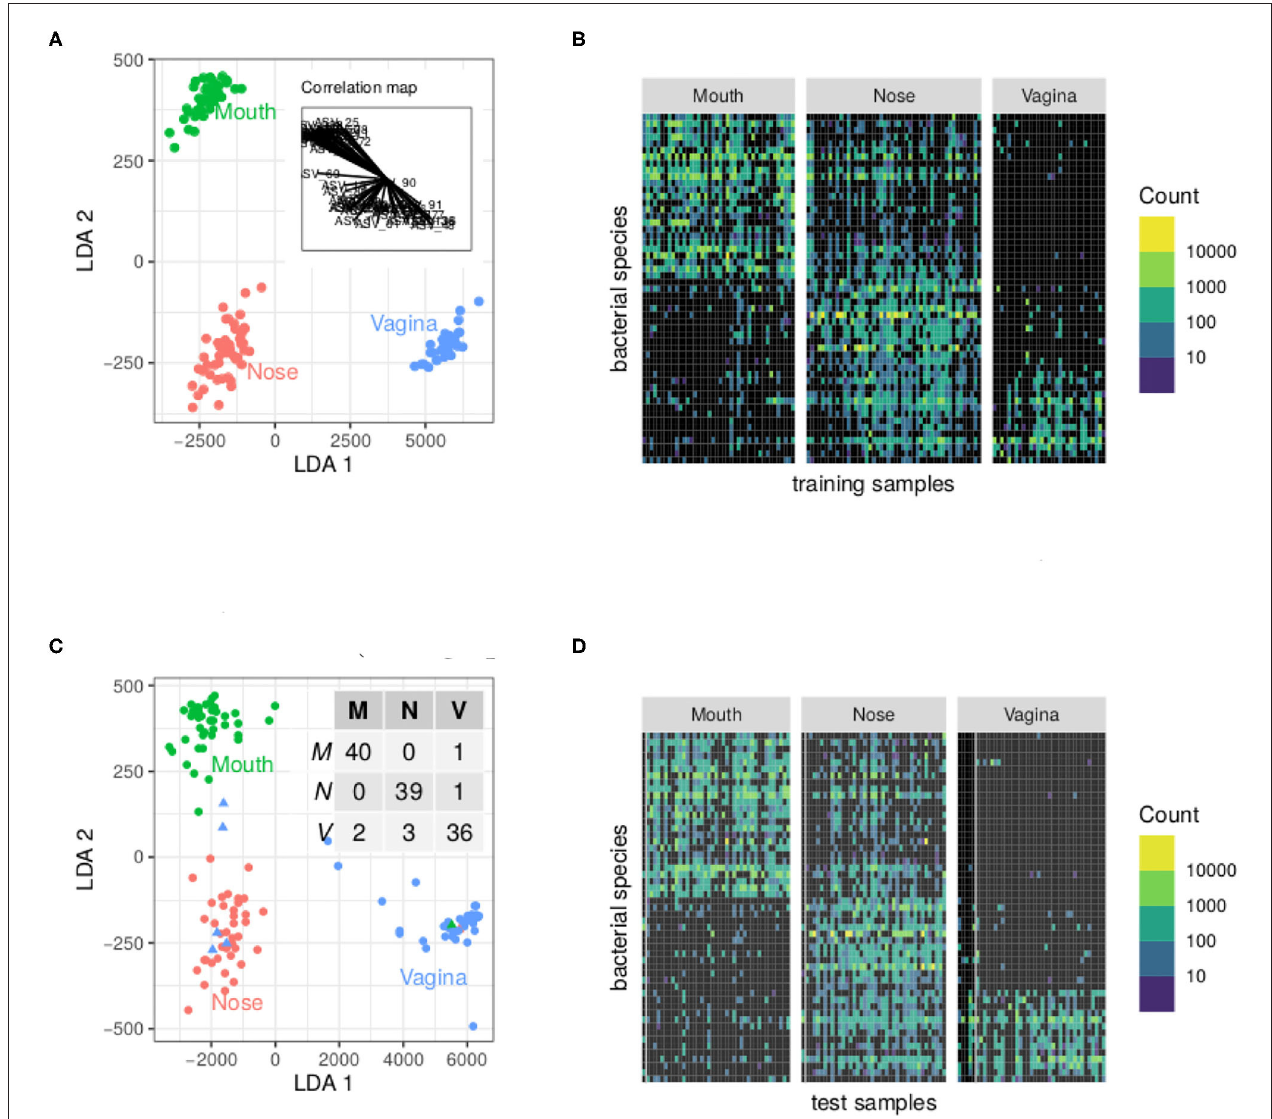
FIGURE 3 | Result of the analysis of the cow holobionts data set with PLN-LDA: a few ASV are enough to find accurately discriminate the body sites. (A) Scores of the training communities on the discriminant axes and contribution of the ASV to each axis (inset graph). (B) Matrix of reordered counts (log-scales). ASV are ordered according to their angle with the x-axis in the correlation map. (C) Scores of the test communities and confusion matrix of the classification (inset table). Misclassified communities are shown by triangles. (D) Matrix of counts as in (B) . Misclassified communities are located on the left of their respective panels and separated from the rest by a gray